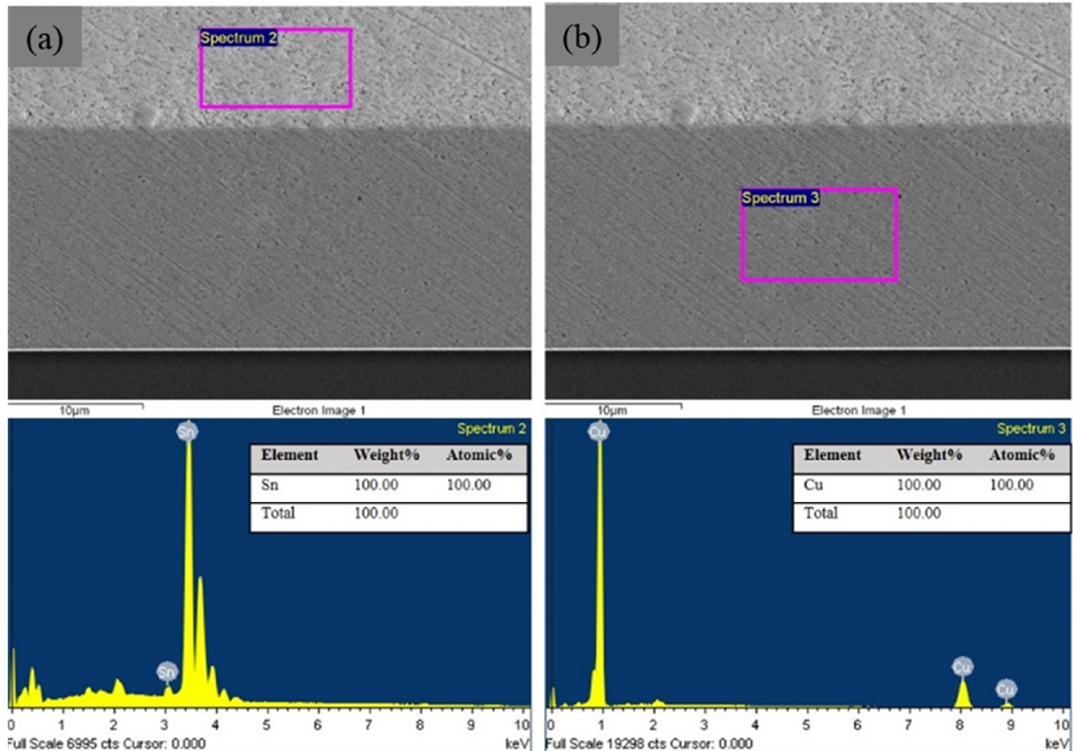
Figure 7. The EDS results of the sample located at ( a ) the Sn film and ( b ) the Cu film after fabrication.